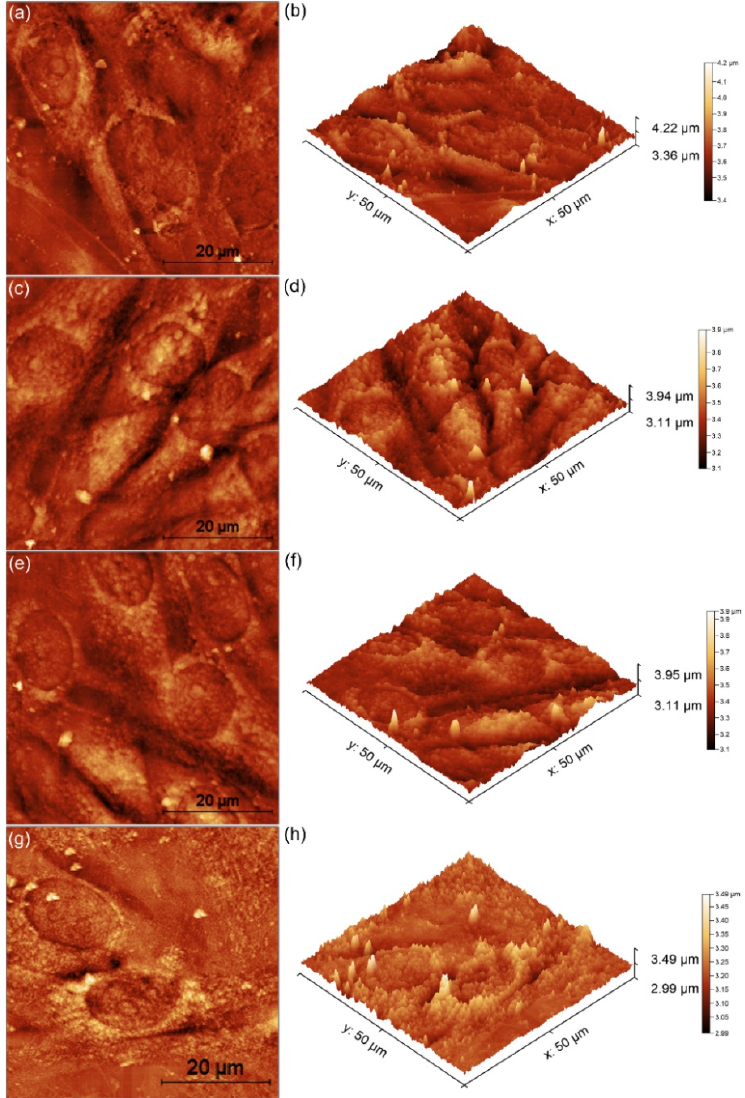
Figure 9. Two-dimensional AFM topography of MG63 cells after 48 h of incubation with Si discs ( a ), HApCh ( c ), 8MgHApCh ( e ) and 30MgHApCh ( g ) composite layers and their 3D representa- tion ( b , d , f , h